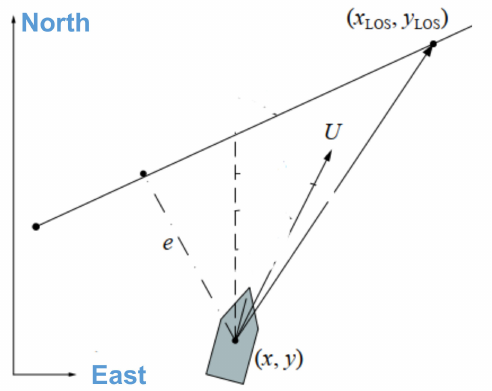
Figure 7. The sketch for LoS